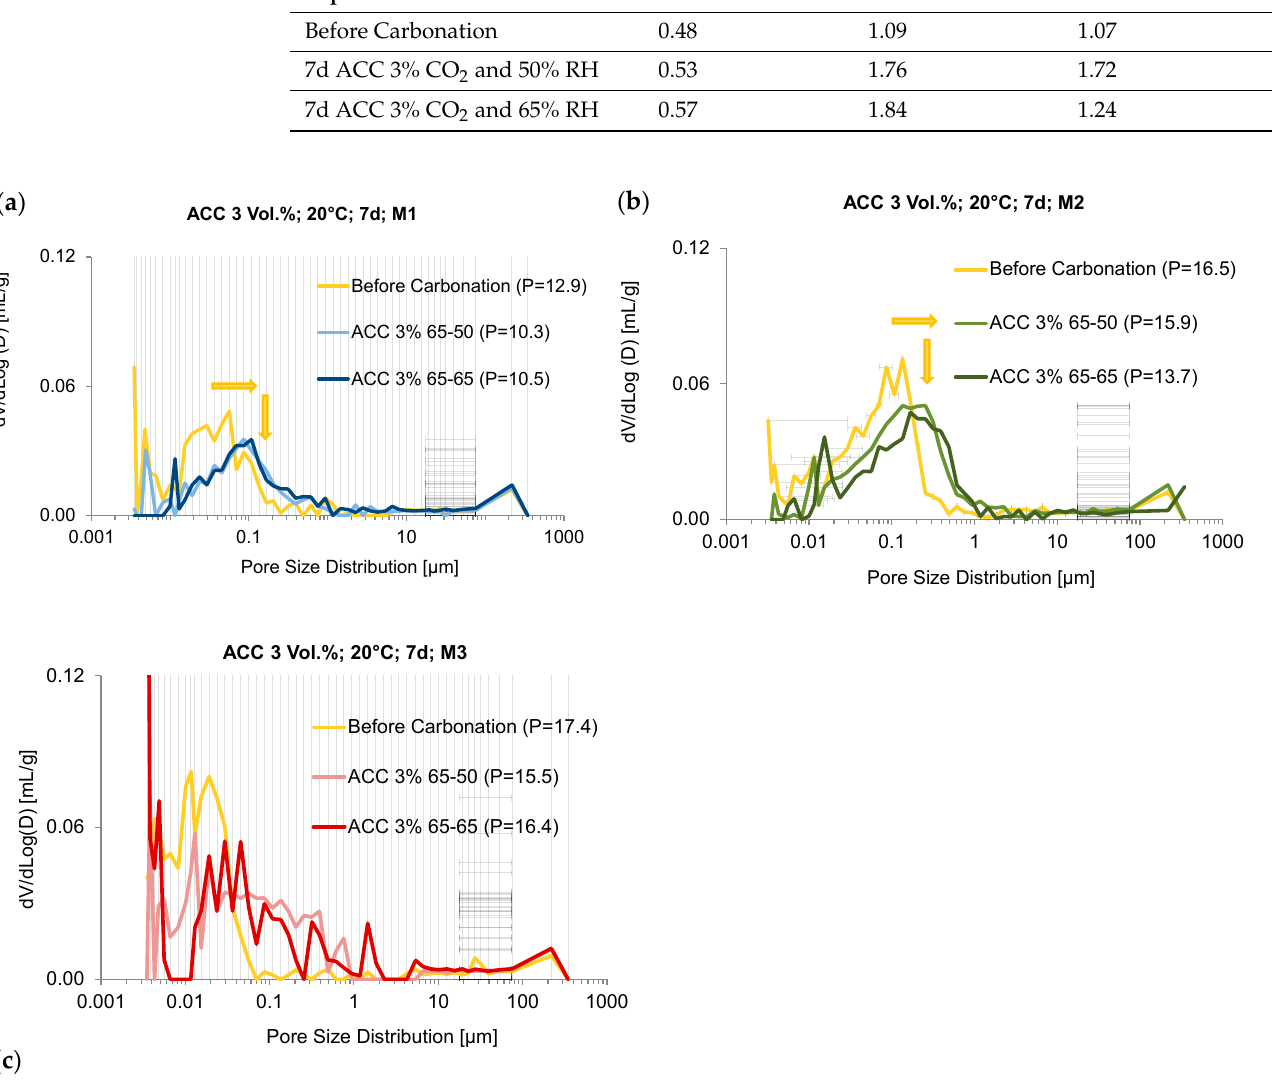
Figure 7. Pore Size Distribution before and after 7 d accelerated carbonation at atmospheric pressure and 3 vol.% CO 2 : ( a ) M1 (mortar with OPC); ( b ) M2 (mortar with limestone); ( c ) M3 (mortar with granulated blast furnace slag. Table 4. Sorption coefficients (kg/(m 2 ∙ h 0.5 )) before and after accelerated carbonation at 50% and 65% RH, 3 vol.% CO 2 , 20 °C and ambient pressure, ACC = accelerated carbonation.